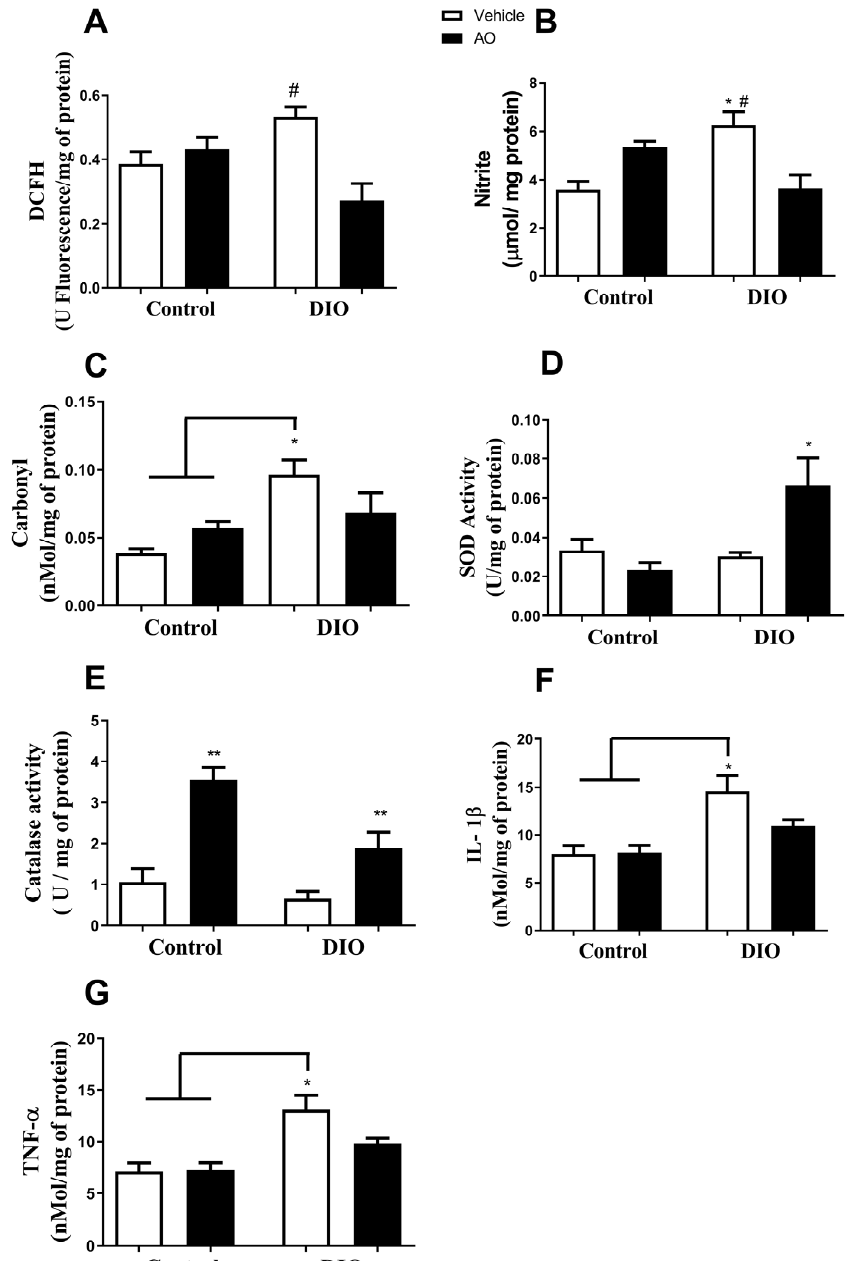
Figure 4. Effects of avocado oil (AO) supplementation on reactive species production, oxidative damage, antioxidant enzyme activity, and cytokine levels in the epididymal adipose tissue of mice with diet-induced obesity (DIO). ( A ) 2 ′ -7 ′ -Dichlorofluorescin (DCFH) levels ( # DIO > DIO + AO, p < 0.05). ( B ) Nitrite levels (* DIO > control; # DIO > DIO + AO, p < 0.05). ( C ) Carbonyl content of proteins (* DIO > control and control + AO, p < 0.05). ( D ) Superoxide dismutase (SOD) activity (* DIO + AO > control, control + AO and DIO, p < 0.05). ( E ) Catalase (CAT) activity (** control + AO and DIO + AO > control and DIO, p < 0.05). ( F ) Interleukin 1 β (IL-1 β ) levels (* DIO > control and control + AO, p < 0.05). ( G ) Tumor necrosis factor- α (TNF- α ) levels (* DIO > control and control + AO, p < 0.05). The results are expressed as the mean ± standard deviation. The data were analyzed statistically using a one-way ANOVA test followed by post hoc analysis using Tukey’s test to compare all pairs of columns. Data were collected from 5 to 7 animals per group. * > control. # > DIO +